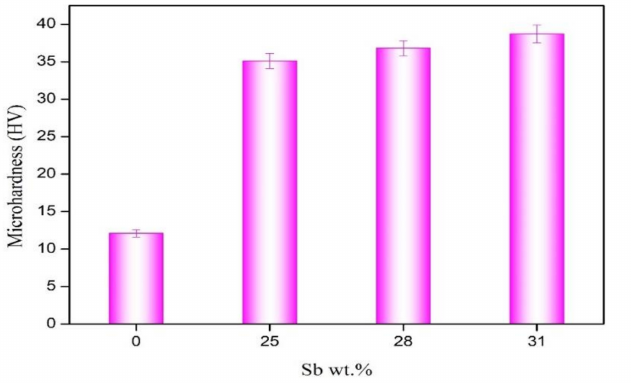
Figure 11. Microhardness of Sn-3.0Ag-0.5Cu- x Sb solder